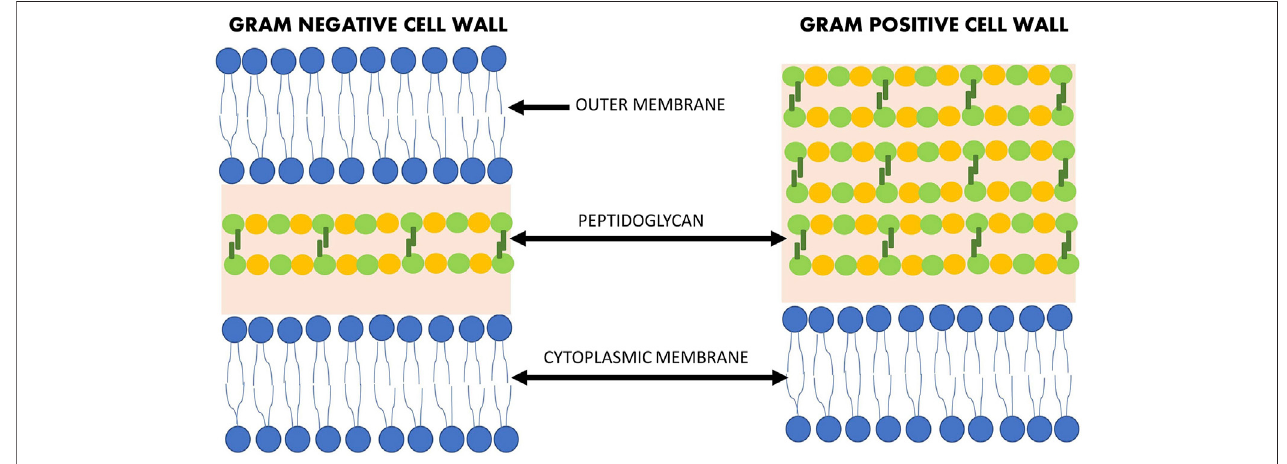
FIGURE 1 | Structural differences between the Gram-negative and Gram-positive bacteria cell